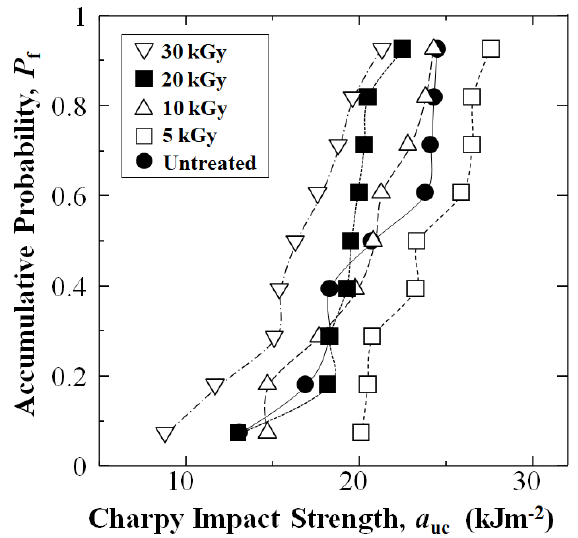
Figure 5. Plot of accumulative probability, P f vs. Charpy impact strength, a uc (kJm −2 ) as a function of HLEBI